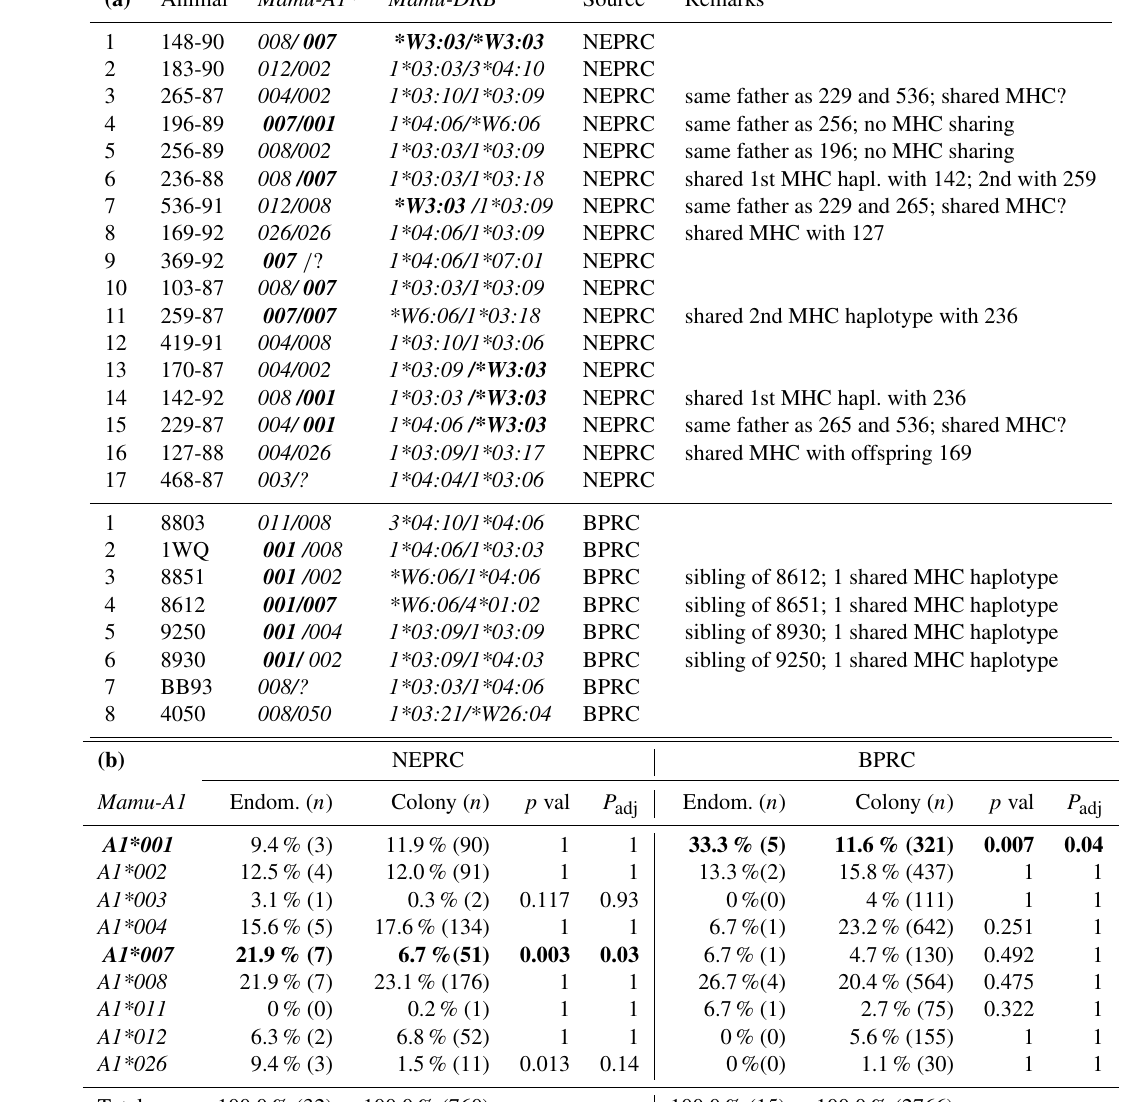
Table 2. (a) Mamu-A1 and Mamu-DRB genotypes of animals diagnosed with endometriosis and their family relationship. A question mark for Mamu-A1 typing indicates that the animal is most probably homozygous for Mamu-A1 . A question mark in the column “remarks” indicates that sharing of a MHC haplotype is possible but cannot be confirmed. Alleles in bold represent those which are present at a higher frequency in rhesus macaques with endometriosis than in healthy animals. (b) Allele frequencies for animals with endometriosis as well as colony frequencies for NEPRC and BPRC are shown. Significant p < 0 . 05 values are